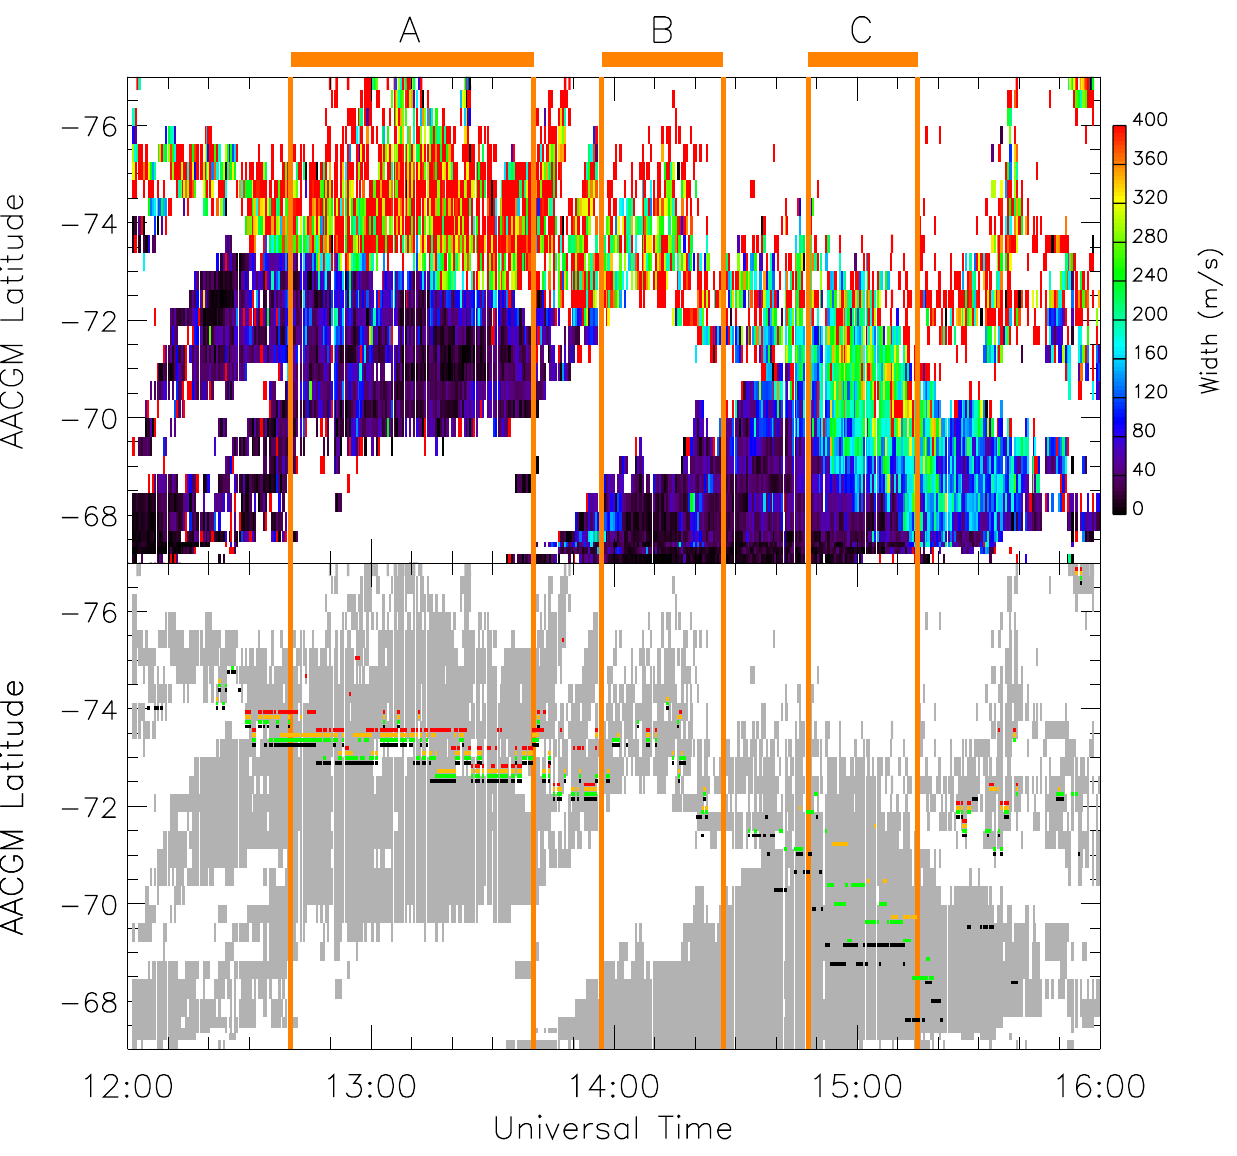
Fig. 2. The top panel presents the unfiltered spectral width variation observed by Halley beam 4 on August 14, 1998. The lower panel presents the results of boundary determinations when applying different spectral width threshold values, 150m/s (black), 200m/s (green), 250m/s (yellow), and 300m/s (red). The orange lines and orange bars highlight three time intervals that are studied in detail, interval A (12:40–13:40 UT), interval B (13:56–14:28 UT), and interval C (14:48–15:15